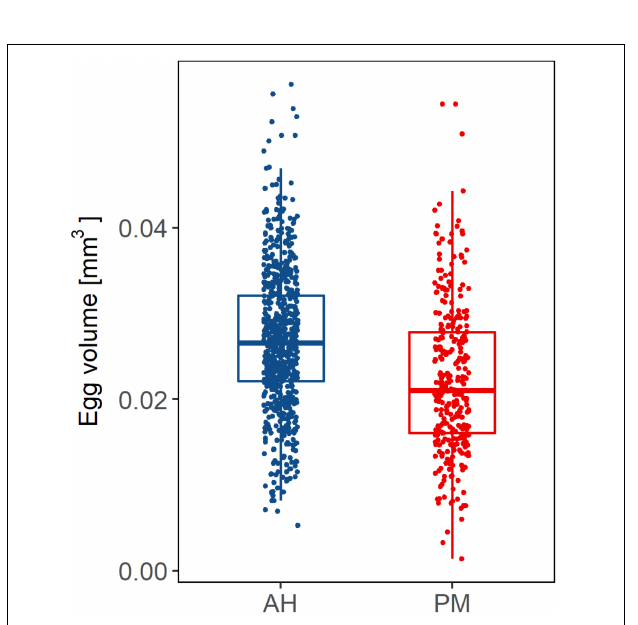
FIGURE 7 | Volume of eggs produced by apparently healthy (blue bars) colonies vs. colonies with partial mortality (red bars) from the Limones site, collected during the spawning season in 2017.